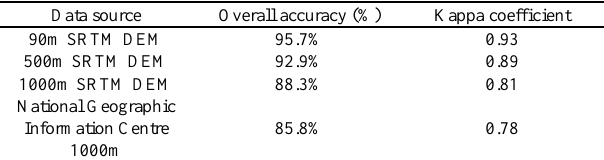
Table 4. Classification accuracy comparison of different